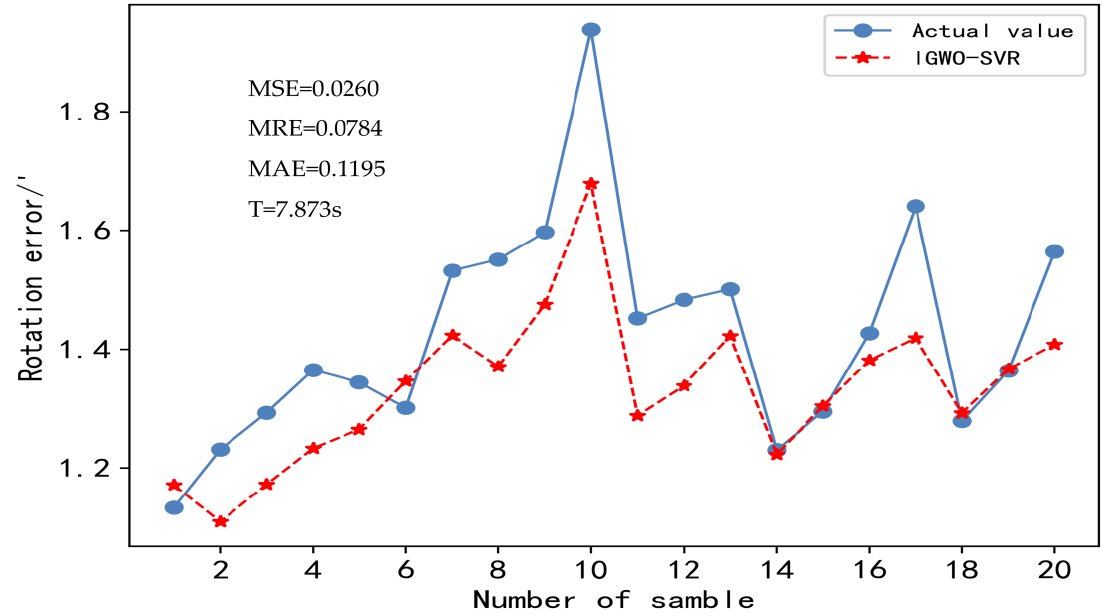
Figure 9. Prediction results of the IGWO-SVR model for rotation errors.